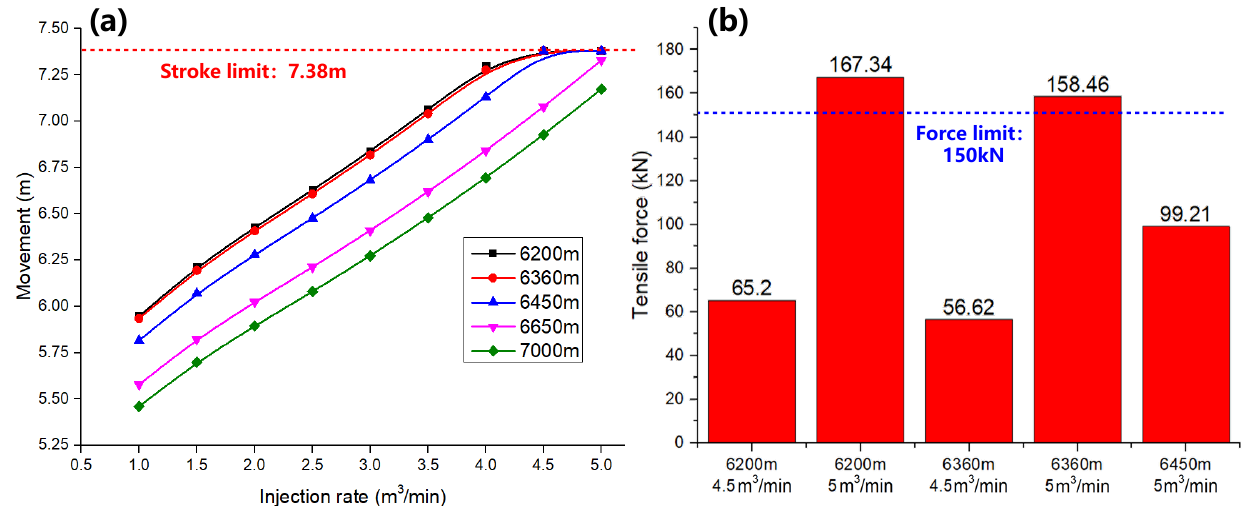
Figure 17. The changes in movement of the expansion joint and corresponding tensile force under different field conditions: ( a ) movement and ( b ) tensile force borne by expansion joint.